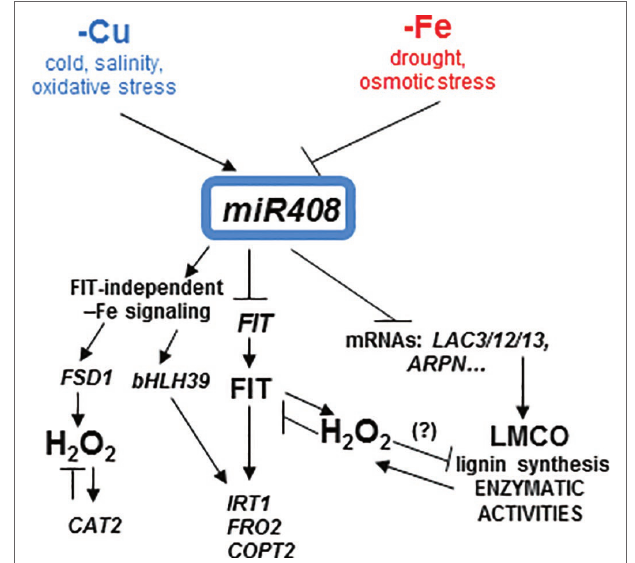
FIGURE 8 | Model for the copper and iron homeostasis interplays through miR408 regulation. Schematic representation of the main miR408 effects on the Fe-deficiency responses observed in the present work. miR408 directly affects the expression of the target genes, such as the mRNA from LMCOs LAC3 , LAC12 , LAC13 ( LAC3/12/13 ), and cyanins (i.e., ARPN ) and their putative promiscuous LMCO role in lignin synthesis and enzymatic activities, such as phenoloxidase, ferroxidase, and ascorbate oxidase. In addition to other abiotic stresses, Cu and Fe deficiencies had the opposite effects on miR408 regulation and their subsequent enzymatic activities. The FIT-independent and FIT-dependent signaling pathways under Fe deficiency were induced or repressed by miR408 , respectively. Fe deficiency induced oxidative stress and hydrogen peroxide (H 2 O 2 ) could play a role in the observed miR408 effects. H 2 O 2 could affect LMCO enzymatic activities, and at least part of the miR408 function could be able to counteract this effect under Fe